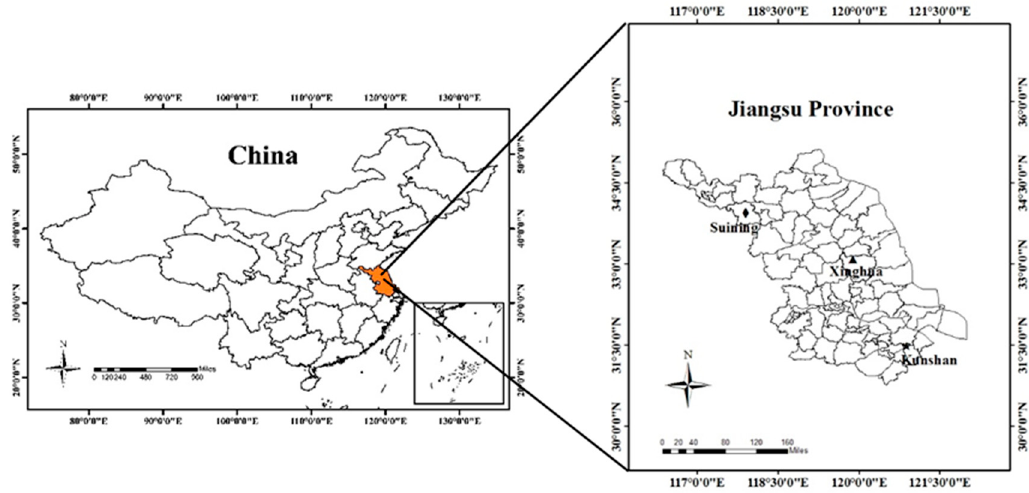
Figure 1. A map illustrating the study site. Wheat experiments were carried out at the Suining, Xinghua, and Kunshan Experimental Stations in Jiangsu Province, China in 2018–2019. Table 1. Basic information about experimental design and data acquisition.